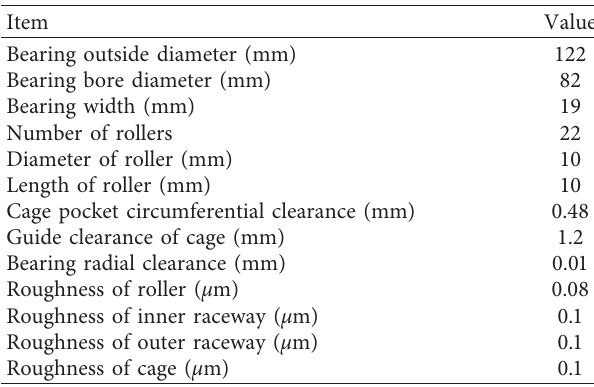
Figure 5: Collision forces between all rollers and cage’s cross beam at the stage of